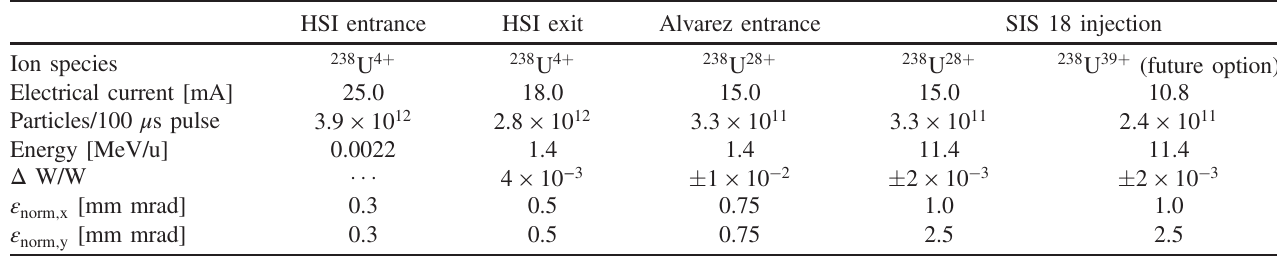
TABLE I. FAIR-design uranium beam parameters at the UNILAC